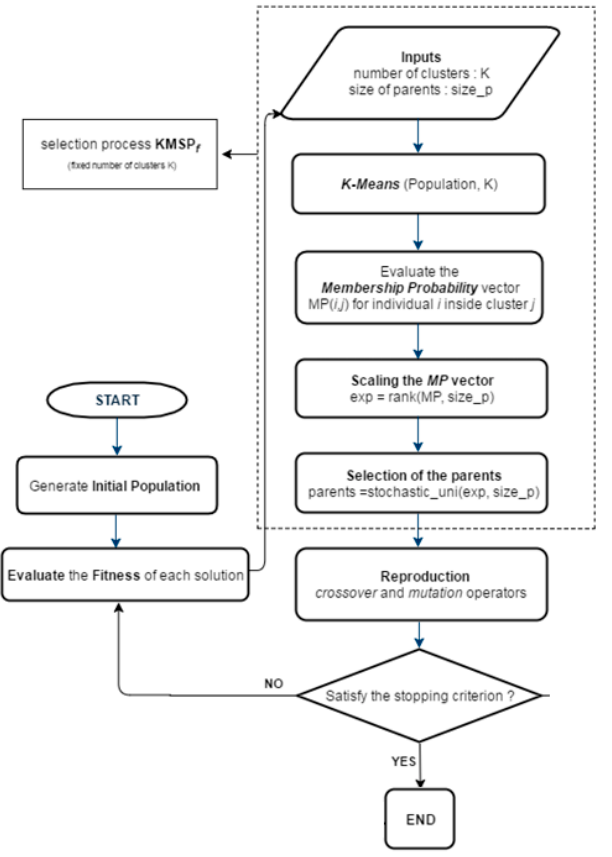
Figure 1. Flowchart of the proposed KGA f technique.